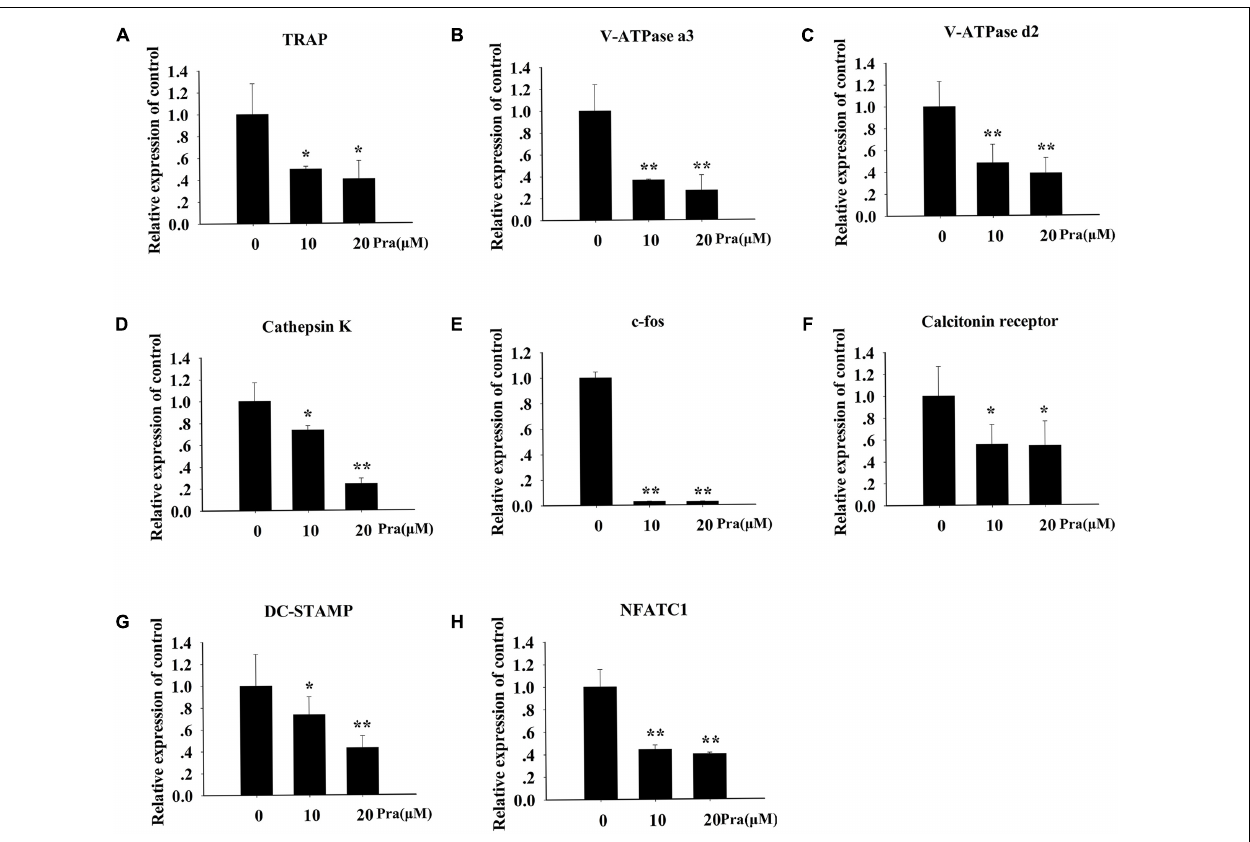
FIGURE 2 | Pra-C suppresses RANKL-induced osteoclast-specific gene expression. BMMs were seeded in six-well plates, and then stimulated with 30 ng/mL M-CSF, 50 ng/mL RANKL, and 10 or 20 µ M Pra-C. Once mature osteoclasts were observed, total RNA was extracted and the expression of osteoclast-specific mRNA [ (A) TRAP , (B) V-ATPase a3 , (C) V-ATPase d2 , (D) Cathepsin K , (E) c-fos , (F) calcitonin receptor , (G) DC-STAMP , and (H) NFATC1 ] was measured using quantitative reverse transcription polymerase chain reaction. All experiments were performed at least three times. All plotted data are the means ± SD. ∗ P < 0.05; ∗∗ P < 0.01, versus 0 µ M